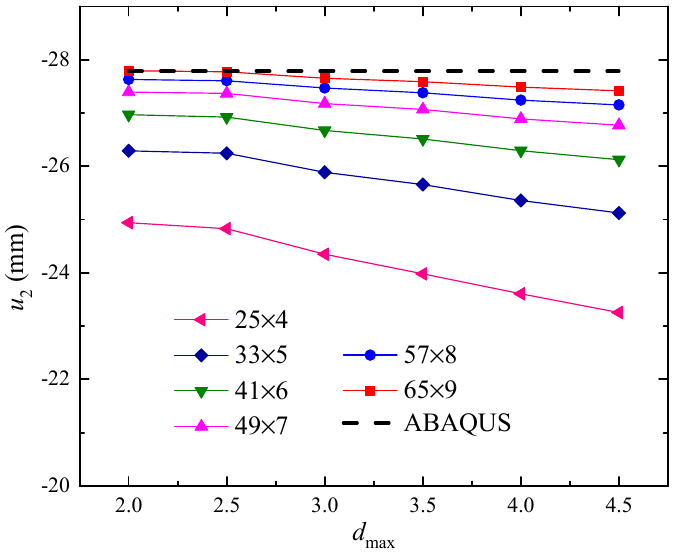
Figure 3. The influence of d max and node distributions on the IICVEFG method.